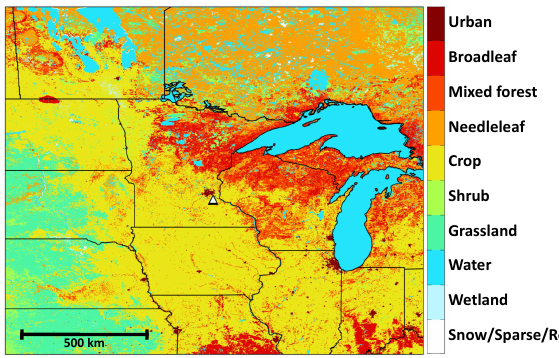
Fig. 1. The KCMP tall tower (white triangle) in Rosemount, MN is located in the US Upper Midwest near the intersection of the main North American ecosystems. The tower is approximately 25km south of the Minneapolis-St. Paul metropolitan